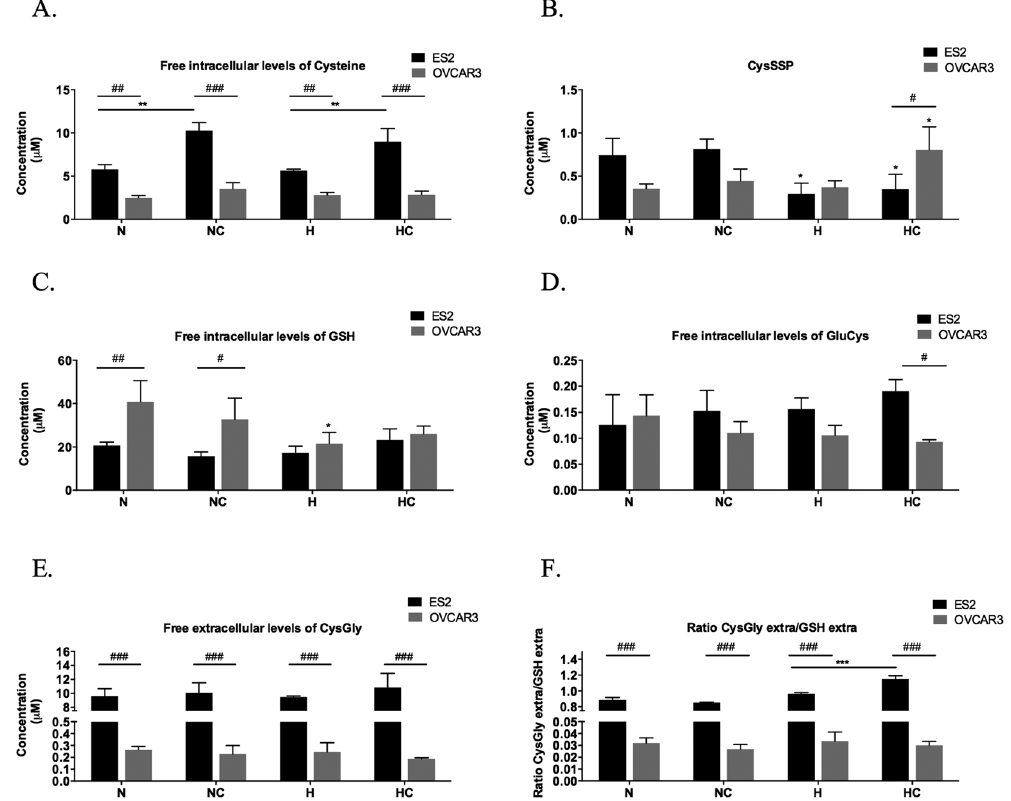
Figure 4. ES2 (OCCC) adaptation to hypoxia relies on free intracellular cysteine availability. Free intracellular levels of ( A ) Cys– cysteine, ( B ) S-cysteinylated proteins – CysSSP, ( C ) GSH – Glutathione, ( D ) GluCys – Glutamylcystein, ( E ) CysGly – Cysteinylglycine and ( F ) free extracellular CysGly/free extracellular GSH ratio in ES2 (black bars) and OVCAR3 (grey bars) cells. N – Normoxia; NC – Normoxia supplemented with cysteine; H – Hypoxia; HC – Hypoxia supplemented with cysteine. Results are shown as mean ± SD. Cardinals represent statistical significance between cell lines. Asteriscs represent statistical significance among treatments within the same cell line or in comparison with the control (normoxia without cysteine supplementation). * p < 0.05, ** p < 0.01, *** p < 0.001 (One-way ANOVA with post hoc Tukey